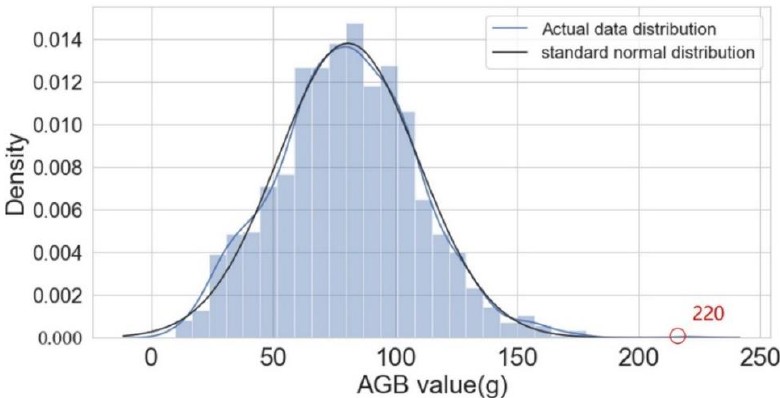
Figure 5. Histogram of the overall AGB sample. The red circle indicates a maximum AGB of 220 g.